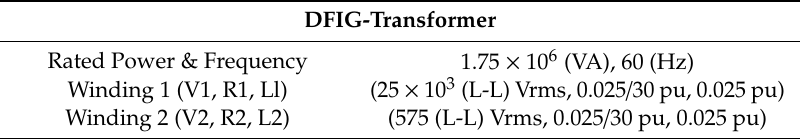
Table A3. Simulation data for 3-Phase two windings Transformer Connecting DFIG